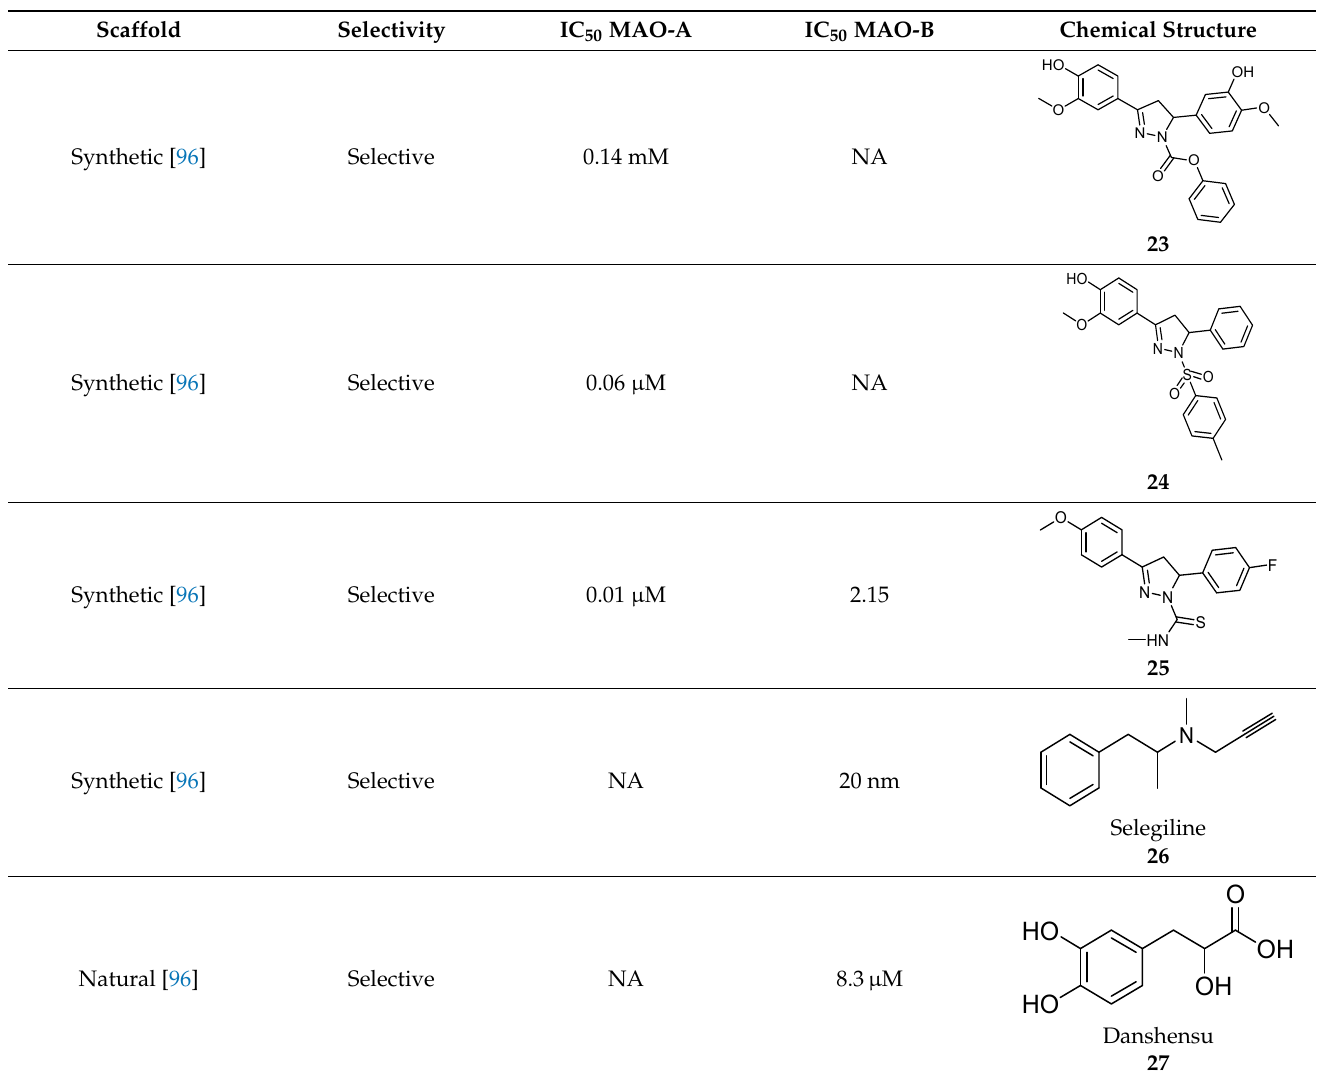
Figure 6. MAO-A pharmacophore model with ( A ) 5-((1H-indol-2-yl)methyl) -3-methyl- 2-thioxo imidazolidin -4-one and ( B ) NSC